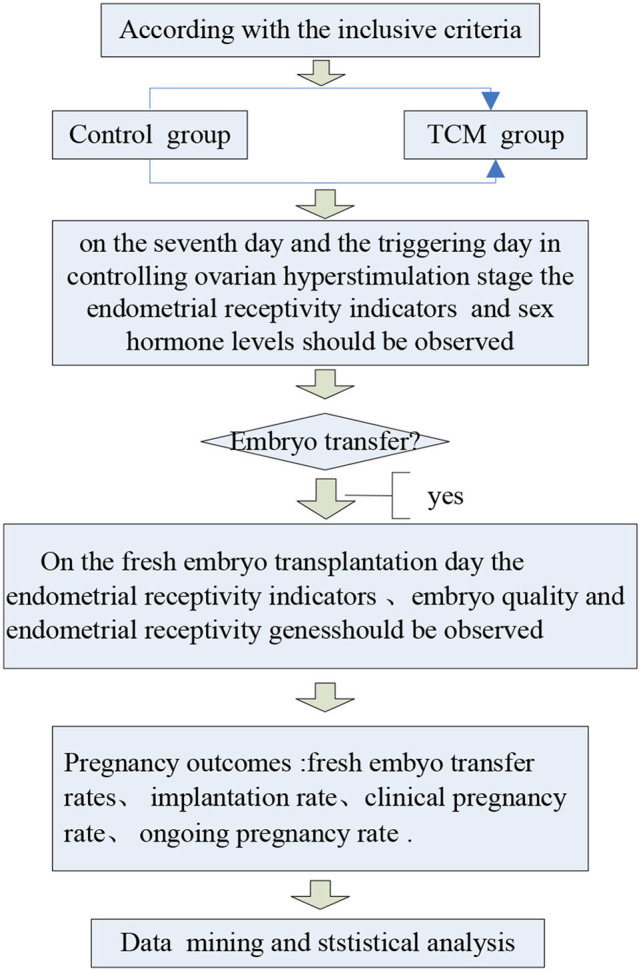
Flowchart of the study to evaluate TCM herbs. Our doctors and researchers had explained the objectives of this study, as well as the procedure and interests of the participants.